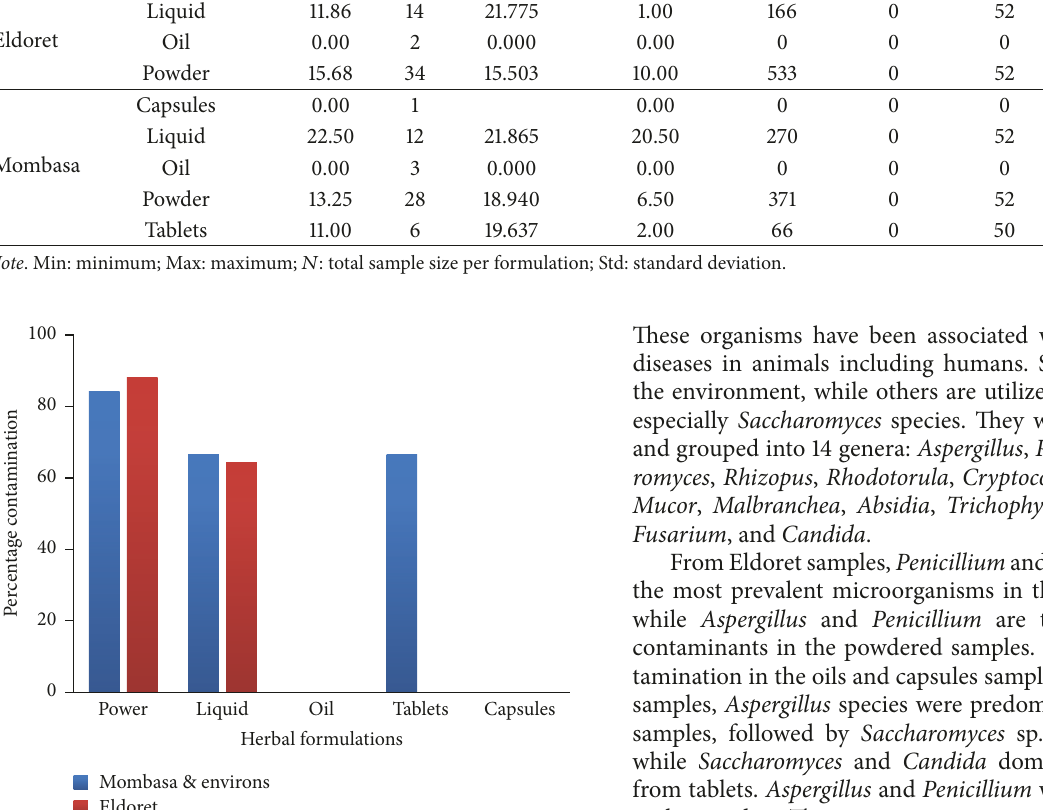
Table 1: Fungal colony forming units per gram (CFU/g) of Mombasa and Eldoret samples after 72 hours incubation ( 𝑛 -100). Site